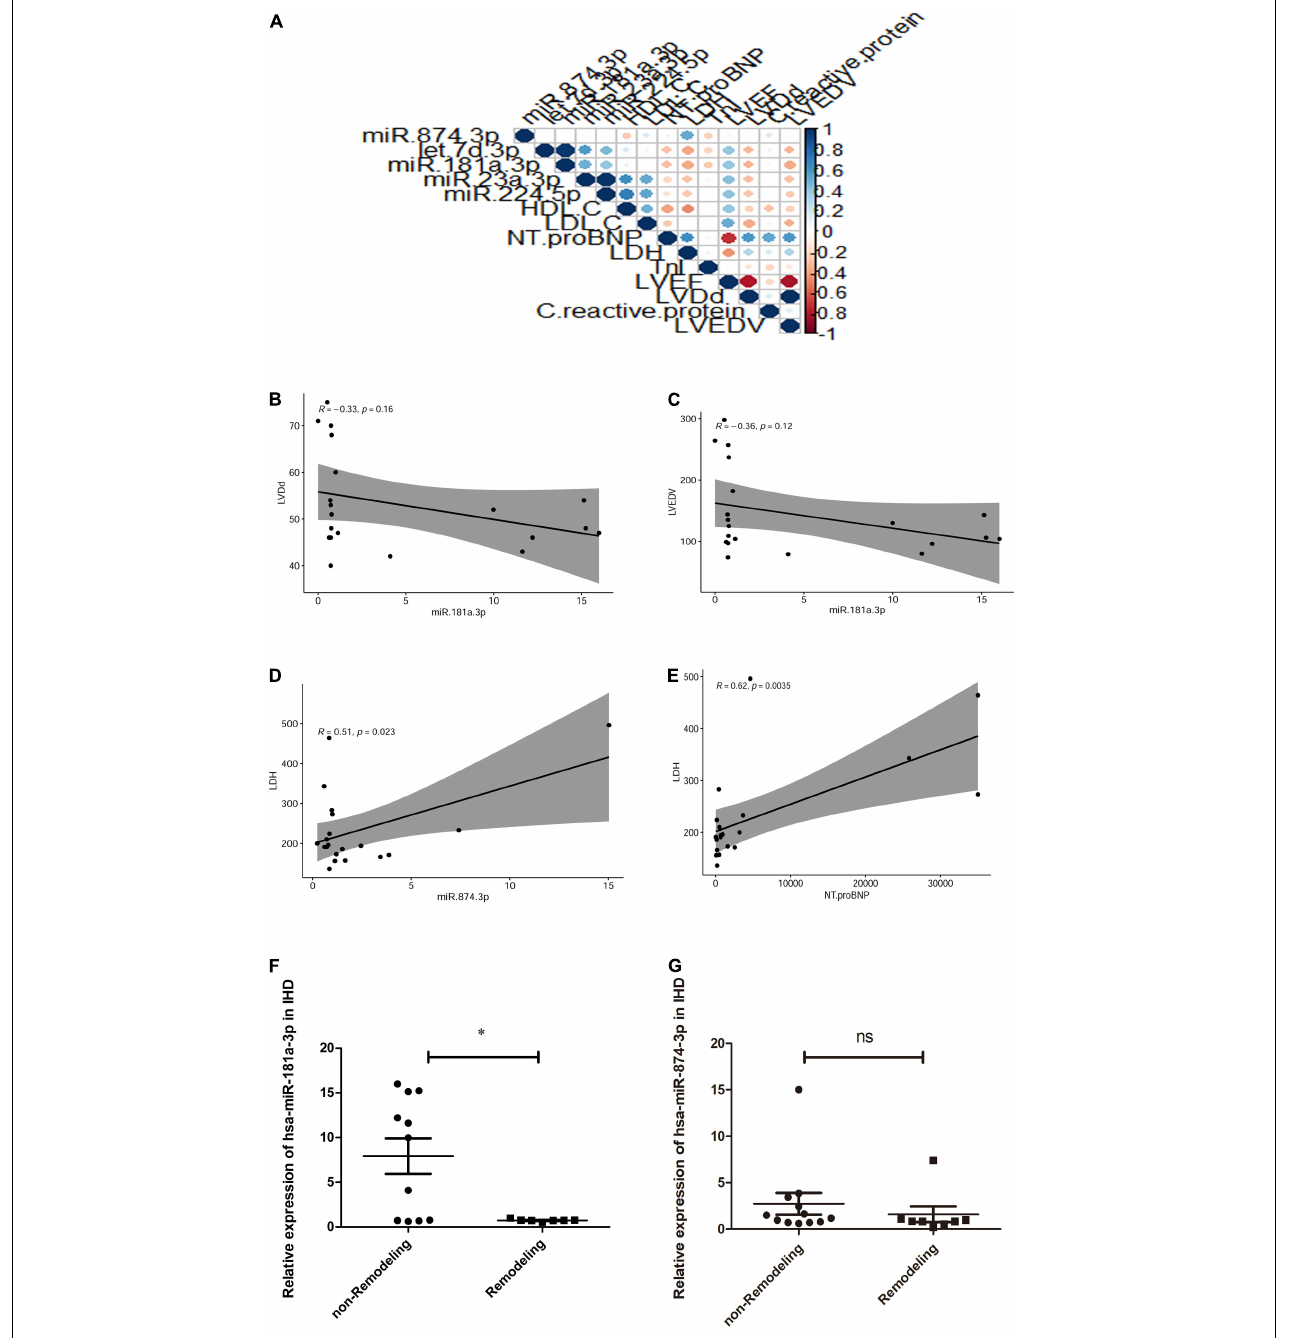
FIGURE 5 | Hierarchical clustering heatmap and the correlation curves of exosome miRNA expression across clinical biomarker levels in patients. (A) Hierarchical clustering heatmap of expression of five exosome miRNAs across clinical biomarker levels in patients ( n = 20) and the correlation of biomarker levels is presented with red (positive) or blue color (negative). Y-axis represents the Rho correlation coefficient and X-axis represents clinical data, such as high-density lipoprotein-cholesterol (HDL-C), low-density lipoprotein-cholesterol (LDL-C), N-terminal pro-brain natriuretic peptide (NT-proBNP), lactate dehydrogenase (LDH), troponin I (TnI), left ventricular ejection fraction (LVEF), left ventricular diastolic diameter (LVDd), left ventricular end-diastolic volume (LVEDV), and expression of circulating exosome miRNAs, including miR-874-3p, Let-7d-p, miR-181a-3p, miR-23a-3p, and miR-224-5p. (B) Correlation between miR-181a-3p expression and LVEDV ( p = 0.16, r = –0.33). (C) Correlation between miR-181a-3p expression and LVDd ( p = 0.12, r = –0.36). (D) Plasma exosome miR-874-3p exhibited a positive correlation with LDH ( p < 0.05, r = 0.50). (E) Levels of LDH were positively associated with NT-proBNP ( p < 0.01, r = 0.62) in patients with STEMI 3–6 months postinfarction. (F) Expression of miR-181a-3p was downregulated in patients with adverse LV remodeling in comparison with patients without LV adverse remodeling. (G) Relative expression of miR-874-3p in patients with and without adverse LV remodeling. * p < 0.05, ns means p > 0.05.